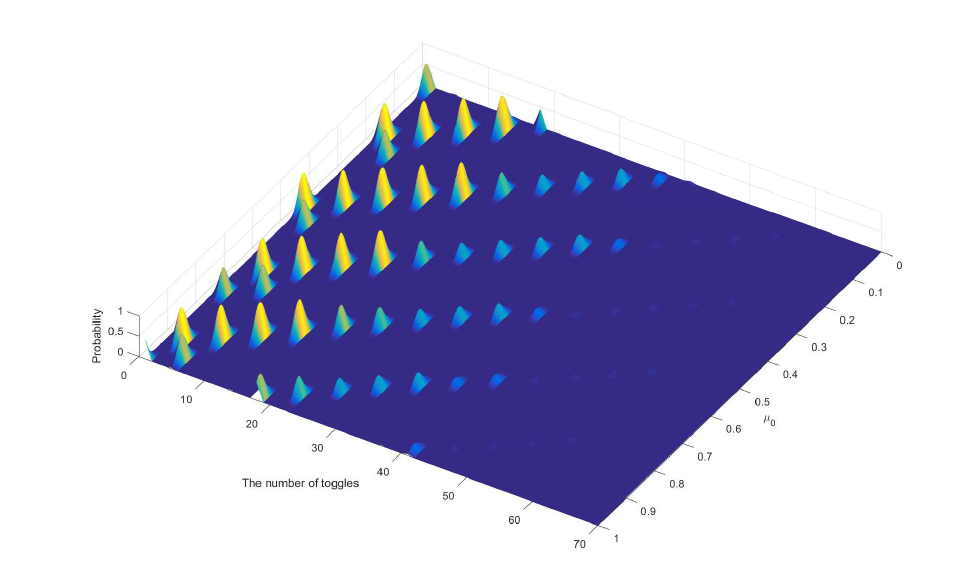
Figure 8: Probabilities of toggle numbers under different µ 0